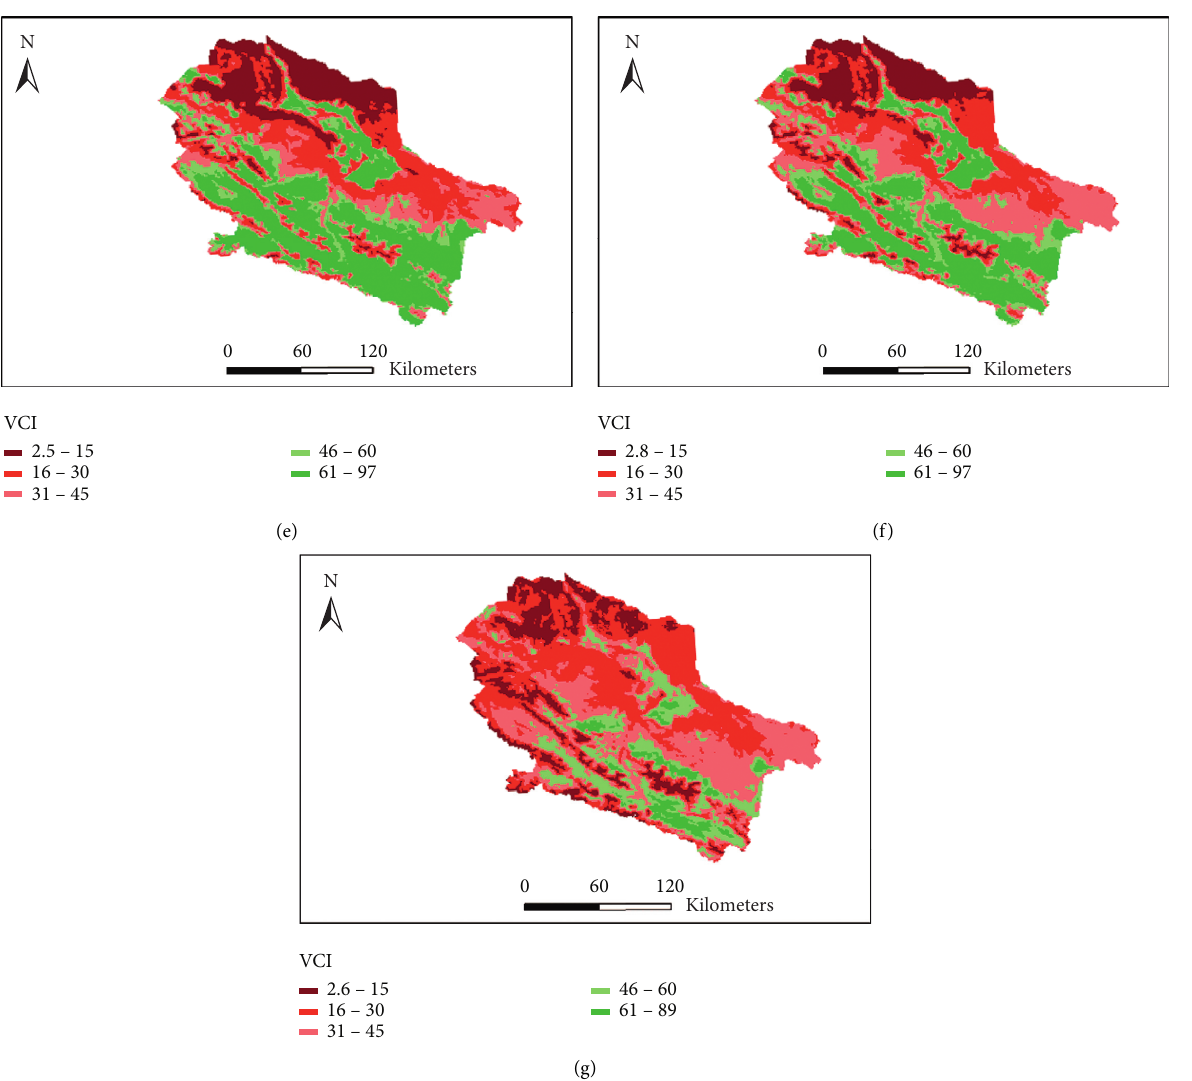
Figure 6: The spatial variation in the average VCI for the growing season (April–October) in the UHRB and MHRB.